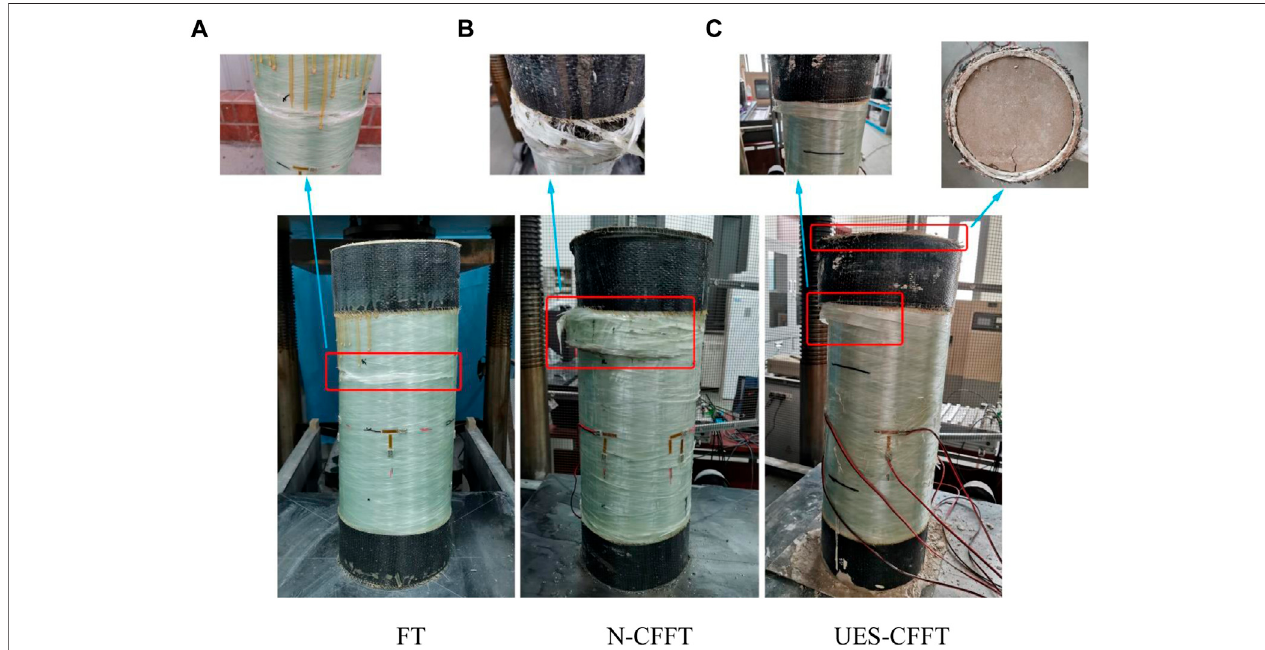
FIGURE 4 | Failure models of the three types of specimens, (A) FT, (B) N-CFFT, and (C) UES – CFFT.